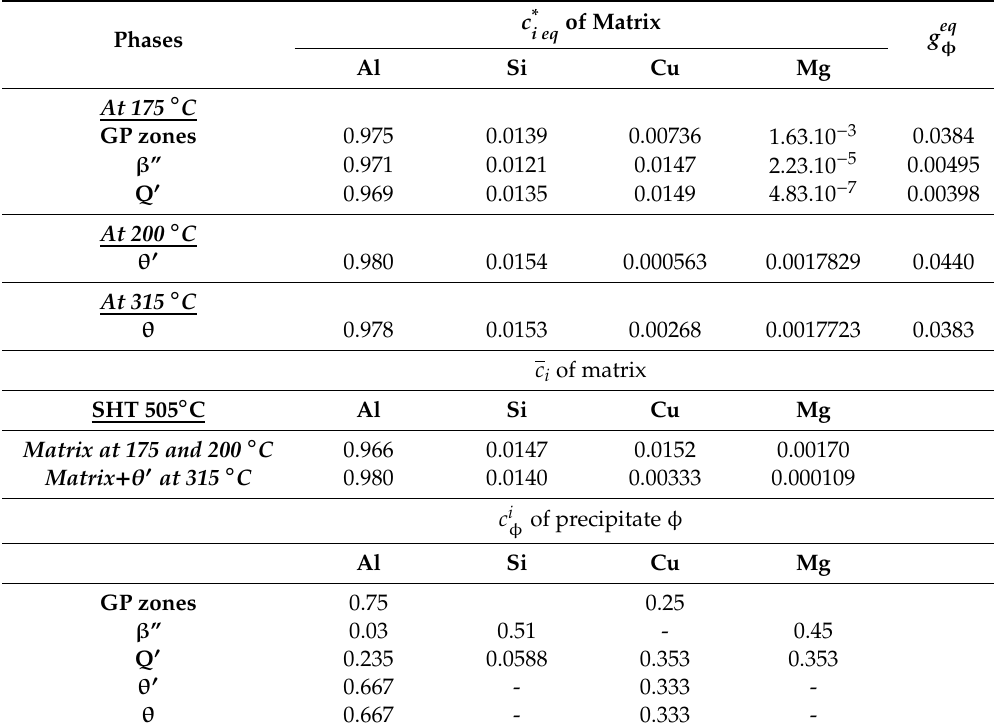
Table A1. For the AlSi7Cu3.5Mg0.15 (Mn, Zr, V) alloy.